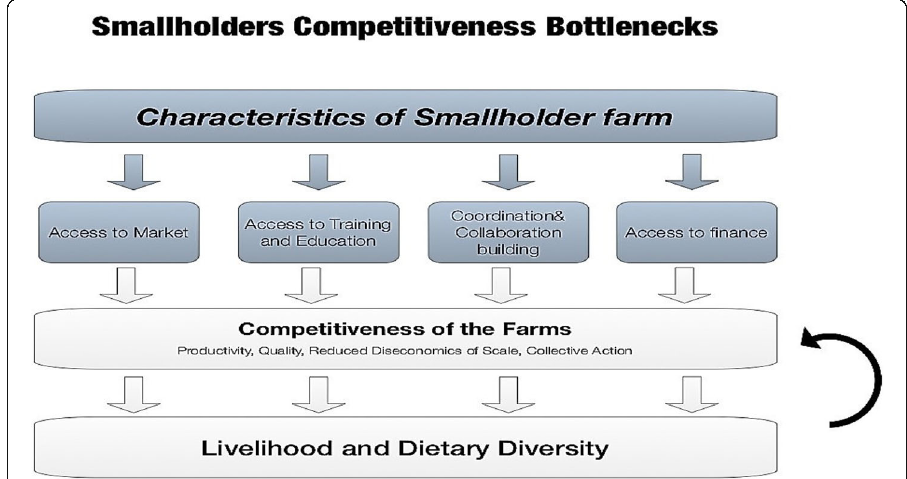
Fig. 1 Competitiveness bottlenecks and pillars for sustainable inclusion. Source: authors